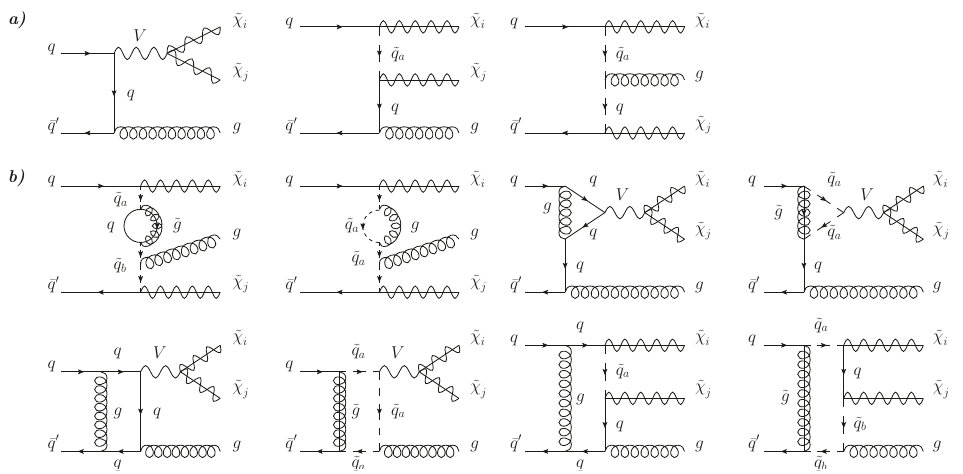
Figure 1 . Representative (a) tree-level and (b) one-loop diagrams for the production of a pair of weakinos, ~ (cid:31) i ~ (cid:31) j , with a jet. Depending on the types i; j of the produced weakinos, V stands for W (cid:6) =Z=(cid:13) , and a; b = 1 ;